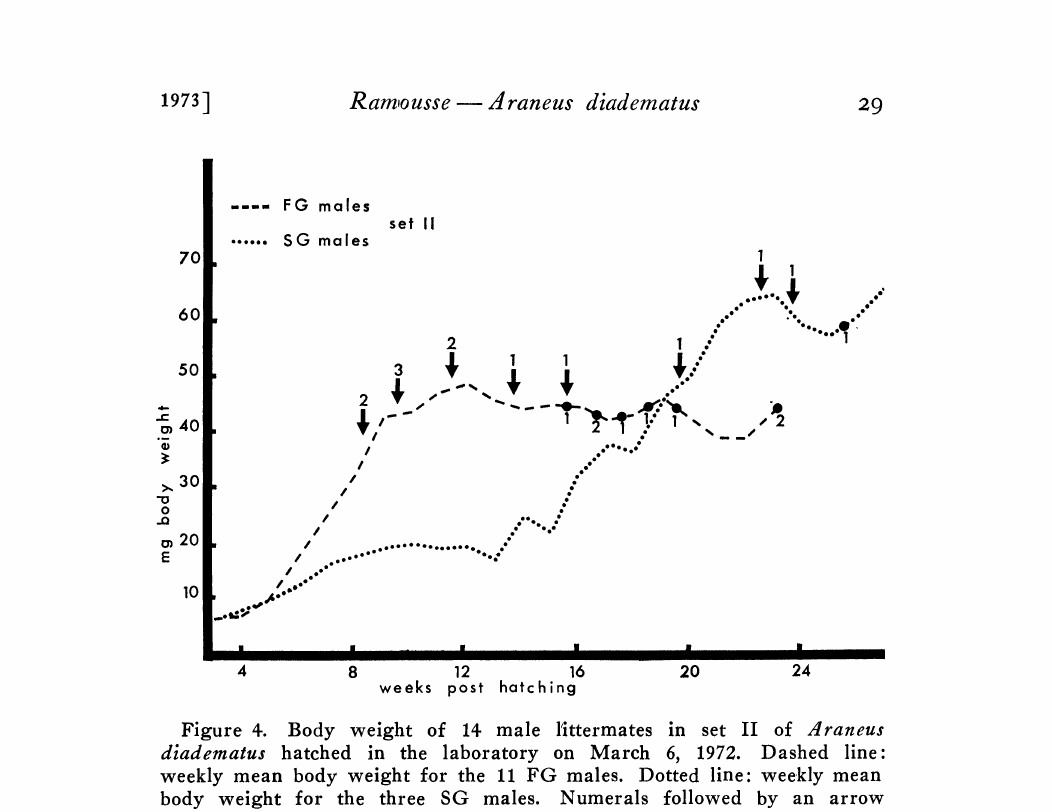
Figure 4. Body weight of 14 male l’ittermates in set II of Araneus diadematus hatched in the laboratory on March 6, 1972. Dashed line" weekly mean body weight for the 11 FG males. Dotted line: weekly mean body weight for the three SG males. Numerals followed by an arrow indicate the number of animals molting fo.r the. last time during a week. The FG animals reached their maximum weight the 12th week post-ha,tch- ing, the SG males reached their maximum the 27th week post-hatching, when the FG males are dead. (Compare with Fig.